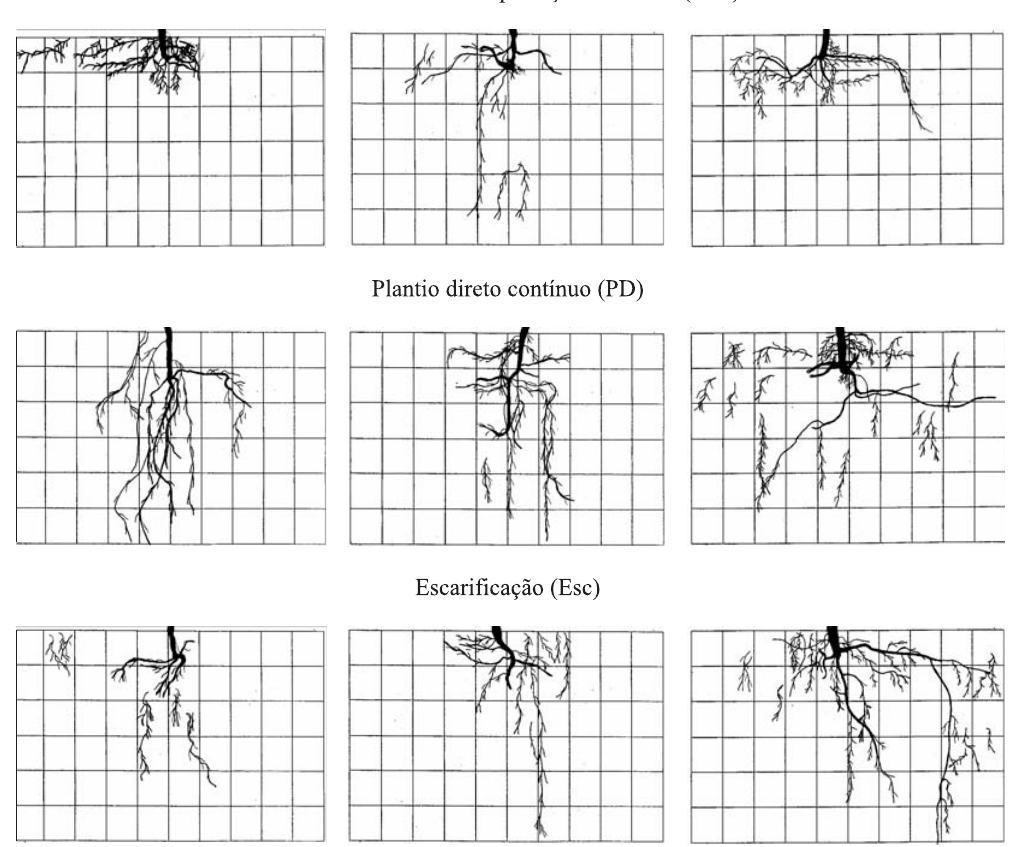
Figura 4. Distribuição radicular do feijoeiro em Latossolo sob plantio direto contínuo (PD), plantio direto com compactação adicional (PDc) e com escarificação (Esc). A dimensão do quadro é de 0,5 x 0,3 m, e cada célula (quadrícula) possui 0,05 x 0,05